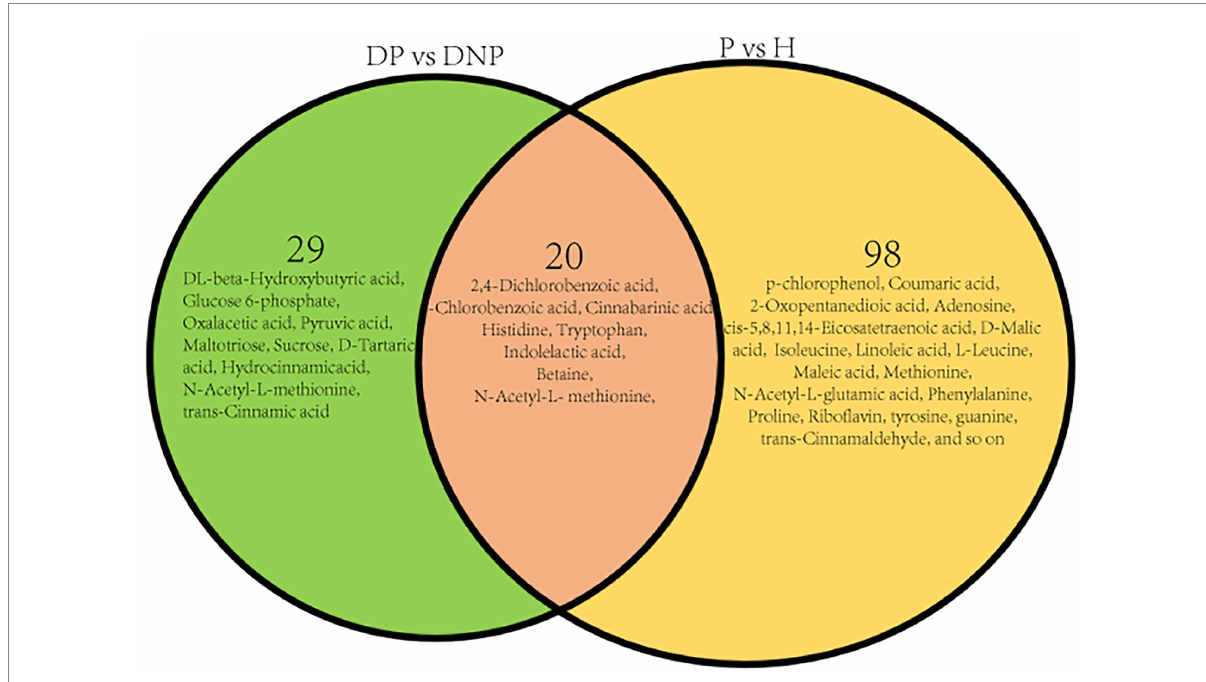
FIGURE 9 Distribution of differential metabolite in four groups. Distribution of differential metabolite between DP and DNP groups, and between P and H groups. There were 20 metabolite which were both differential metabolite between the DP and DNP group, and between the P and H groups. Besides, 29 metabolite were differential metabolite between the DP and DNP group only; in addition, 98 metabolite were only differential metabolite between the P and H groups